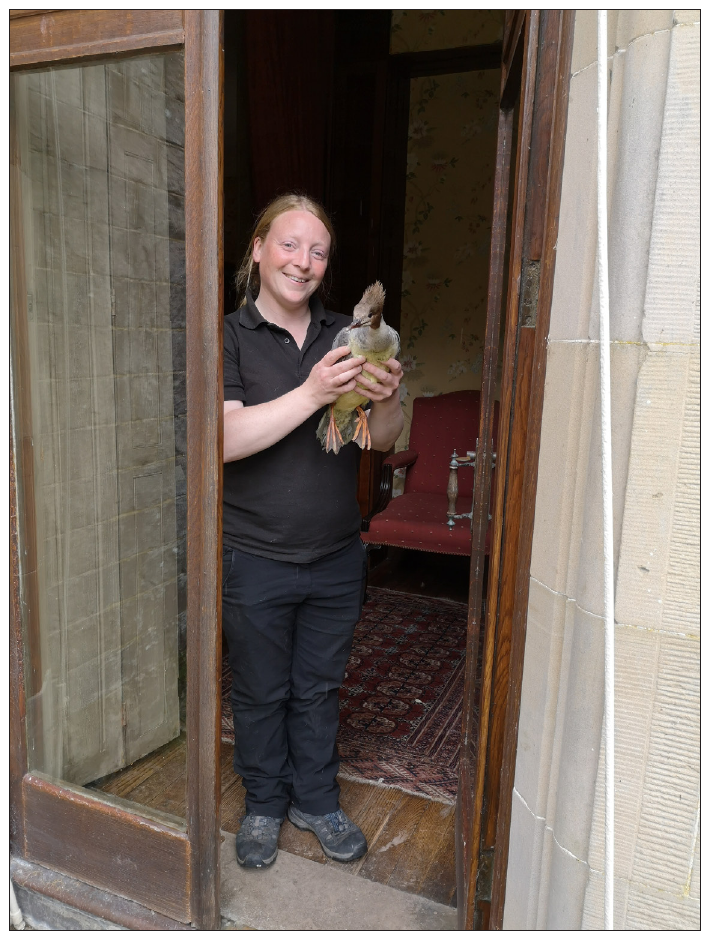
Fig. 2 : The Abbotsford goosander with a member of staff from the SSPCA. Photo: Abbotsford